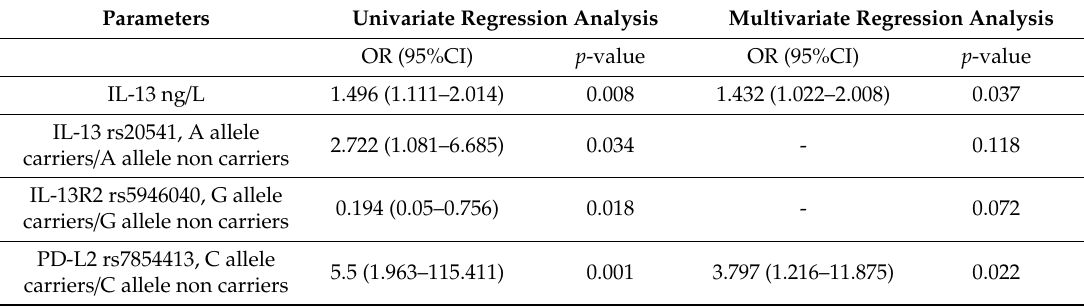
Table 5. Simple and multiple regression analysis for advanced fibrosis progression in NASH patients. Parameters Univariate Regression